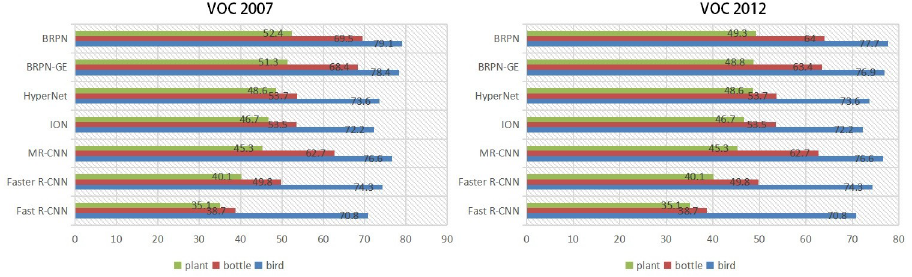
Fig 12. Small-object detection results on the PASCAL VOC 2007 and VOC 2012 test